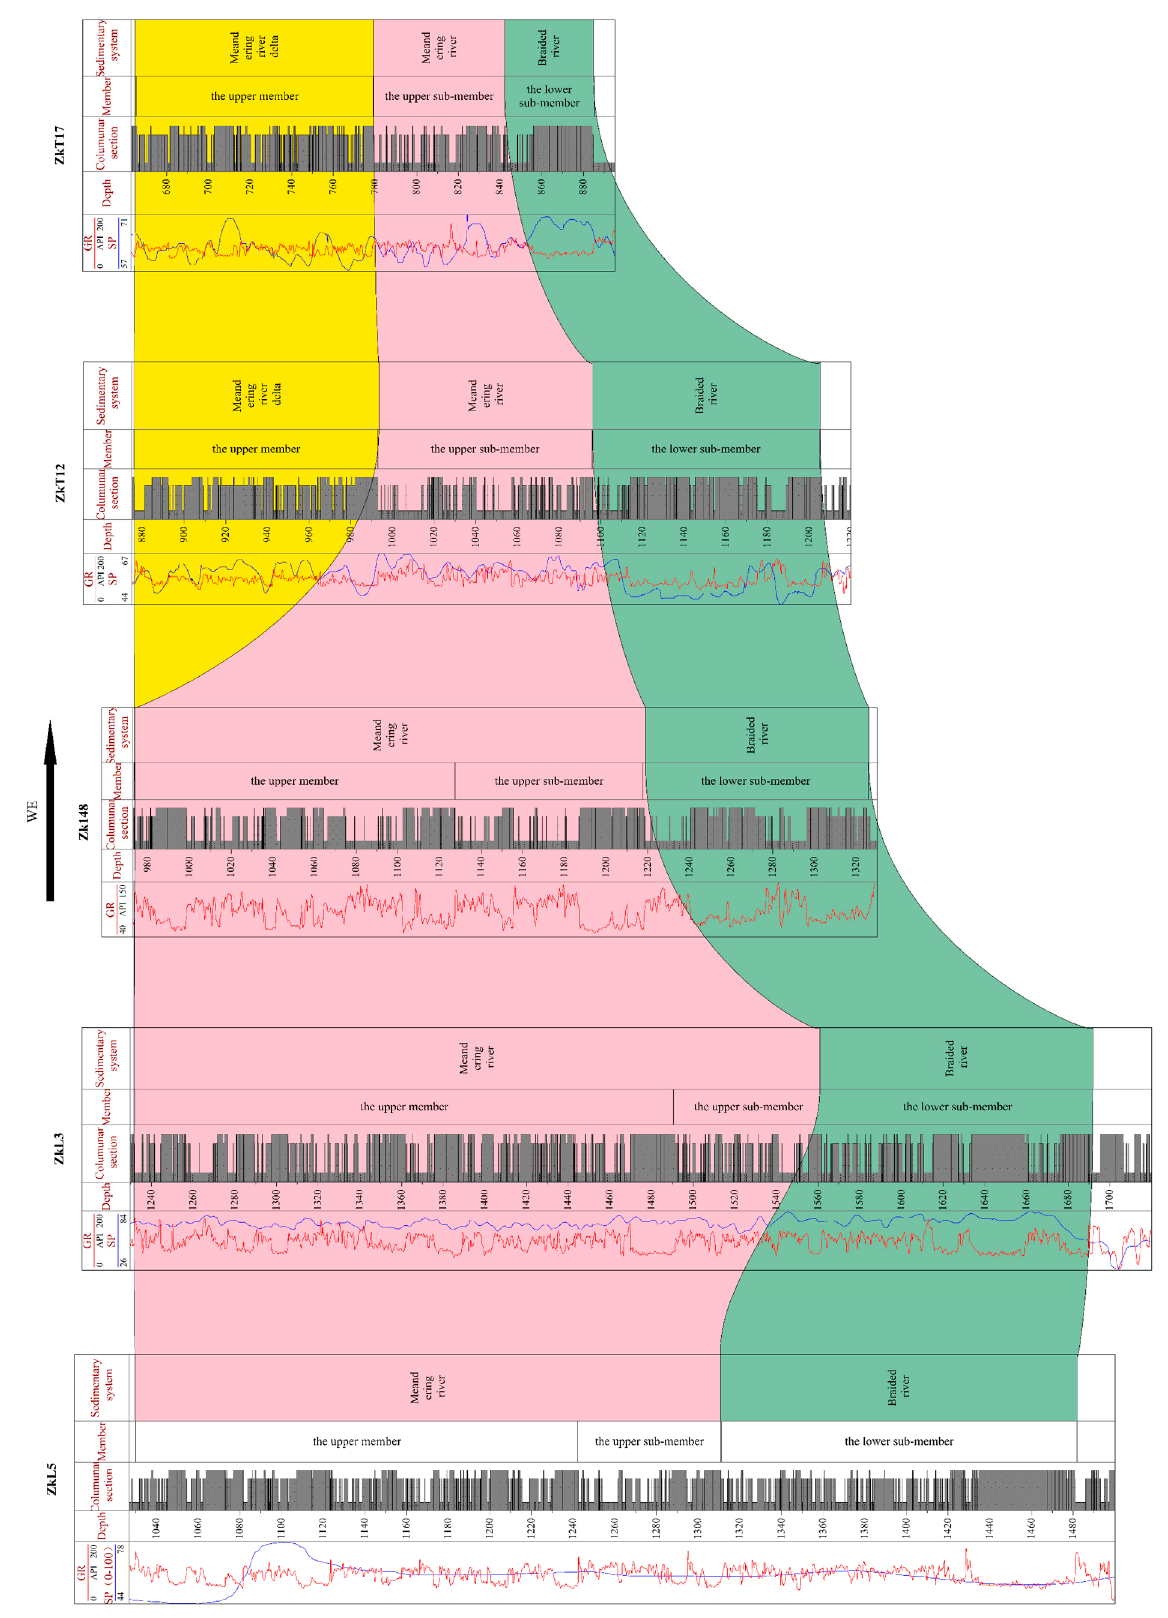
Figure 5. Well-correlation section of the Jurassic Zhiluo Formation in the basin’s Middle part from west to east.